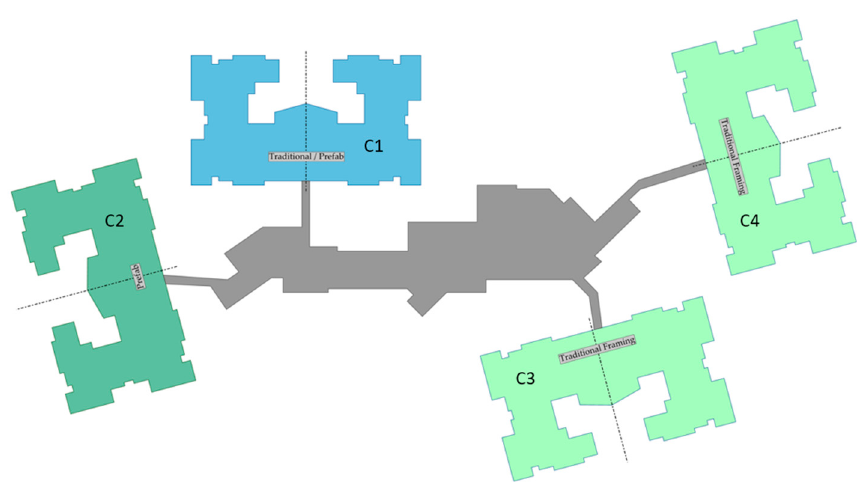
Figure 2. Project site layout showing configuration of buildings.